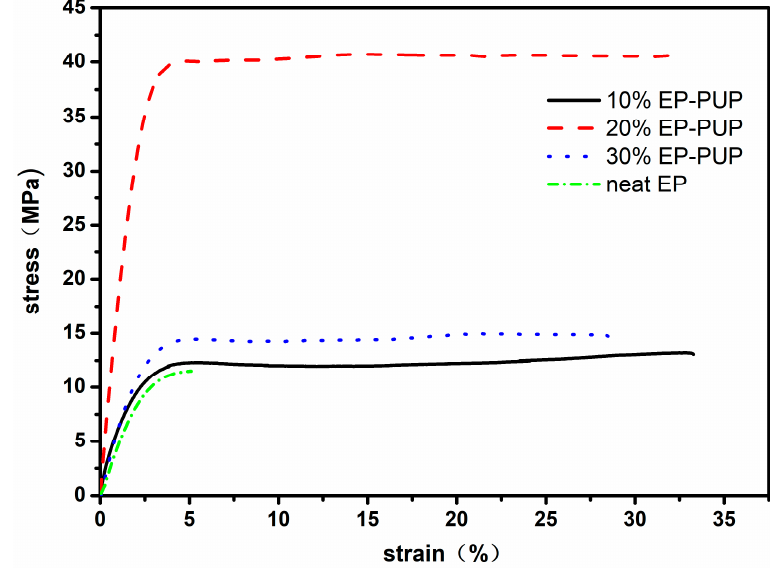
Figure 2. Stress–strain curves of polyurethane (PU)-modified epoxy resins with different raw material ratios.